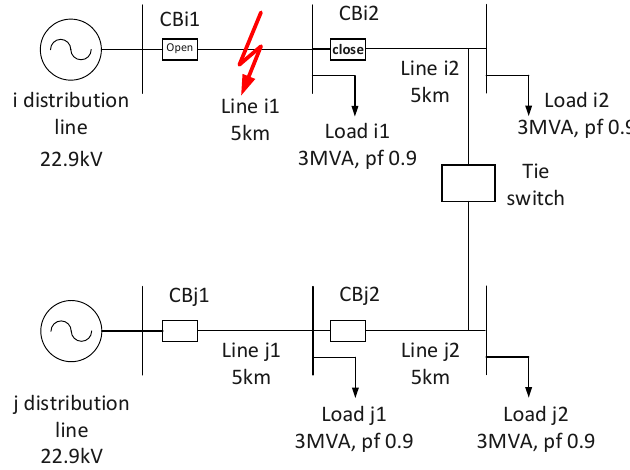
Figure 6. Simple distribution system.